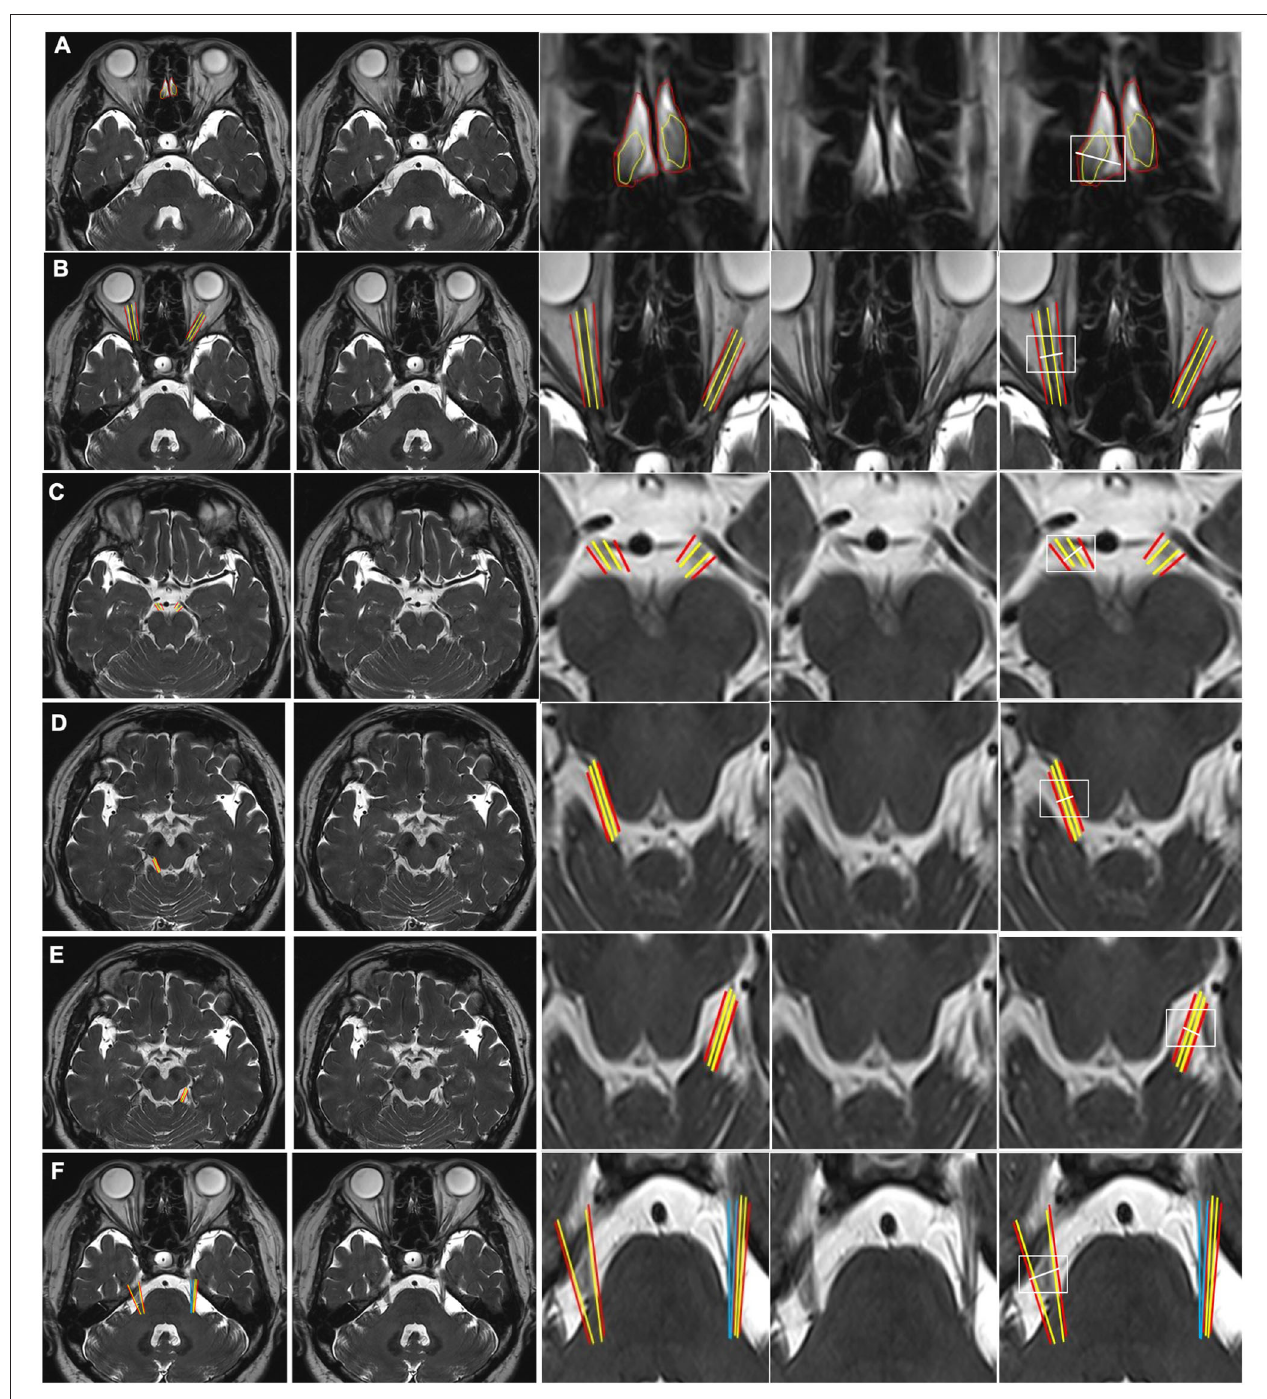
FIGURE 1 | CSF-filled peri-neural spaces surrounding the first five cranial nerves (CN I-CN V). (A) Olfactory nerves (CN I), (two original images, two corresponding magnified images and measurement location); (B) Optic nerves (CN II) (two original images, two corresponding magnified images and measurement location); (C) Oculomotor nerves (CN III) (two original images, two corresponding magnified images and measurement location); (D) Right trochlear nerve (CN IV) (two original images, two corresponding magnified images and measurement location); (E) Left CN IV (two original images, two corresponding magnified images and measurement location); and (F) Trigeminal nerves (CN V) (two original images, two corresponding magnified images and measurement location). Space within the yellow lines: respective nerve (hypointense signal). Space between the red and yellow lines: peri-neural space (hyperintense signal). Space between the blue lines: CN V (hypointense signal). White line: measurement location. All images were generated from the first experiment as described in the method section.